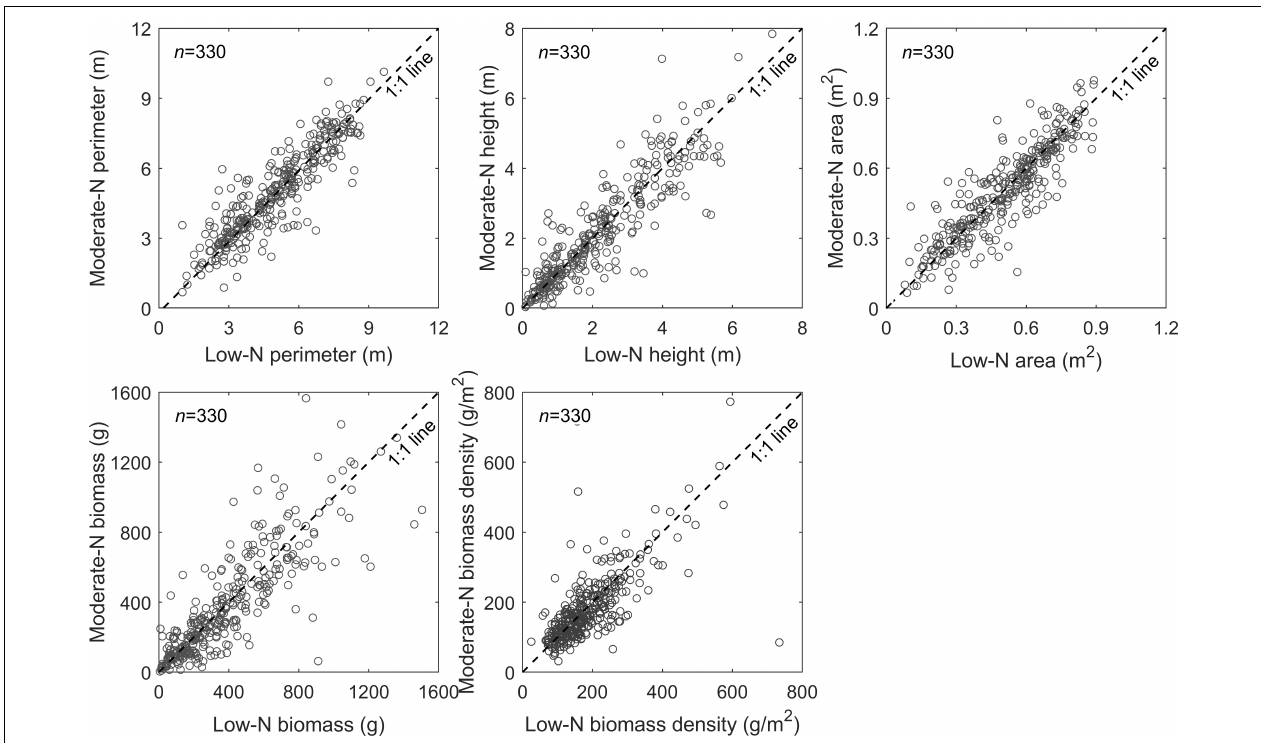
FIGURE 8 | Comparisons of two contrasting N treatments for each genotype with four replicates (2 replicates per N treatment). The comparisons are performed among the plant canopy perimeter, height, and area, as well as single plant biomass and biomass-density, where the data for the plant canopy perimeter, height, and area are derived from peak season of plant growth (i.e., September 25, 2019). Each data point represents an average of two replicates per each N treatment (low and moderate) for a total of 330 switchgrass